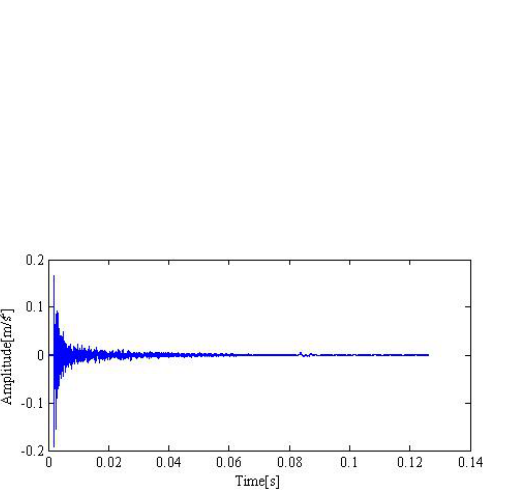
Fig. 4. Time domain waveforms of level I blockage